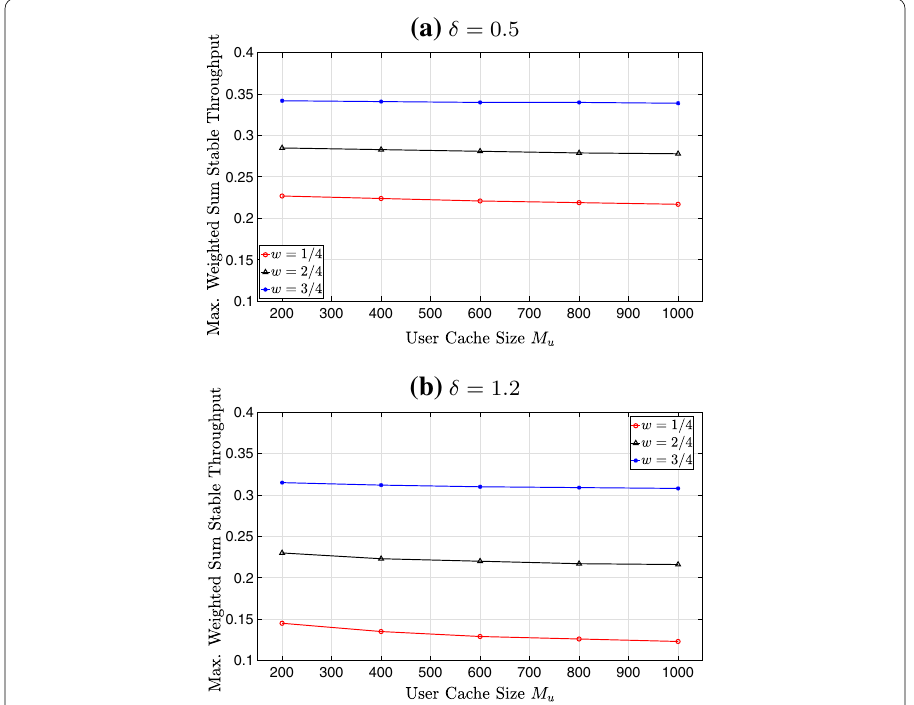
Fig. 6 The maximum weighted sum throughput vs. M U when the queue at S is stable ( (cid:31) = 0.4 ) and α = 0.7 using different values of w for: ( a ) δ = 0.5 and ( b ) δ =